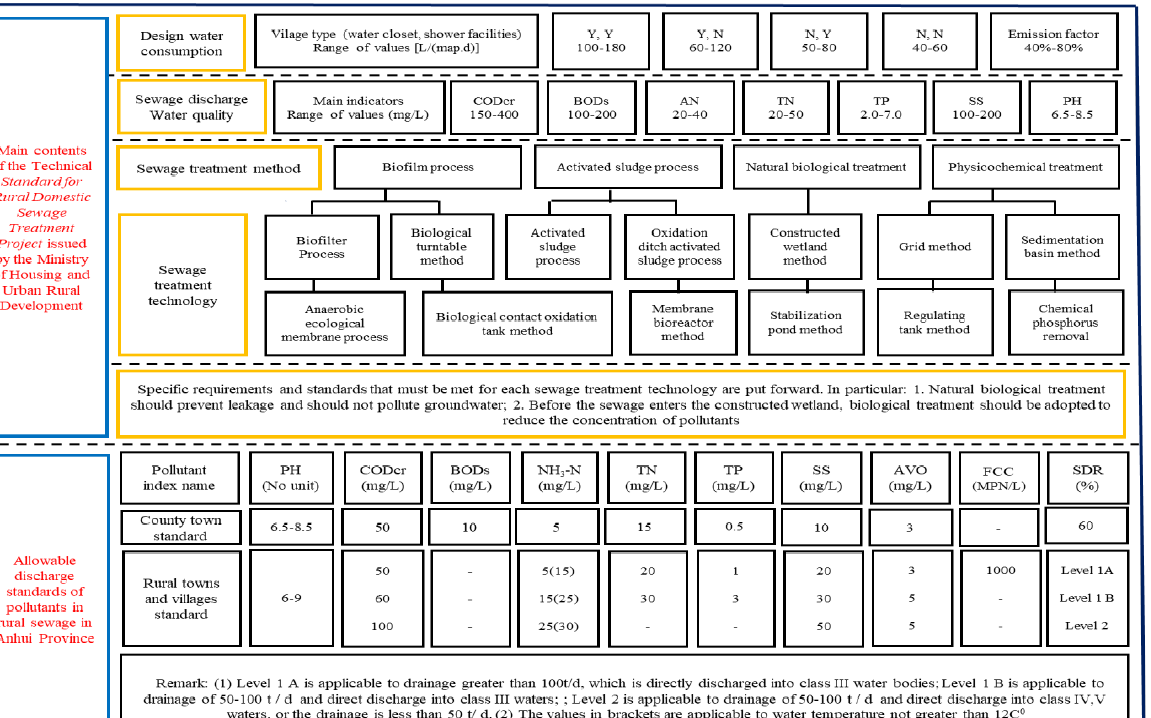
Figure 1. Main contents of Technical Standards for Rural Domestic Sewage Treatment Engineering .